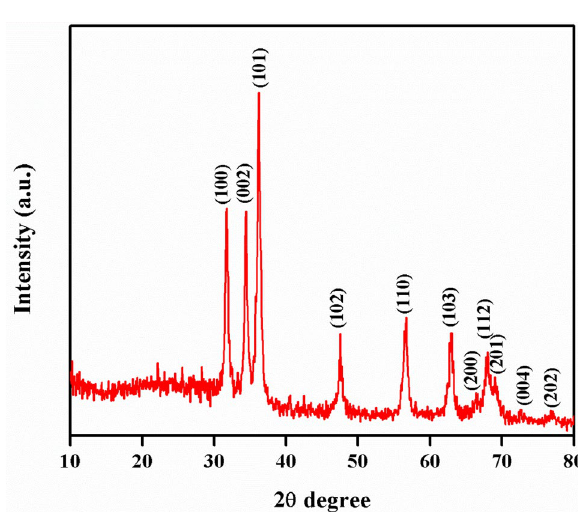
Figure 5. XRD analysis of synthesized ZnO NPs.